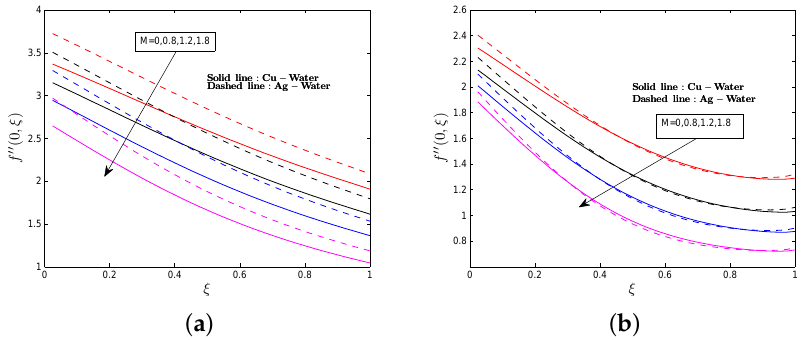
Figure 12. Skin friction coefficient for various values of M . ( a ) vertical plate; ( b ) horizontal